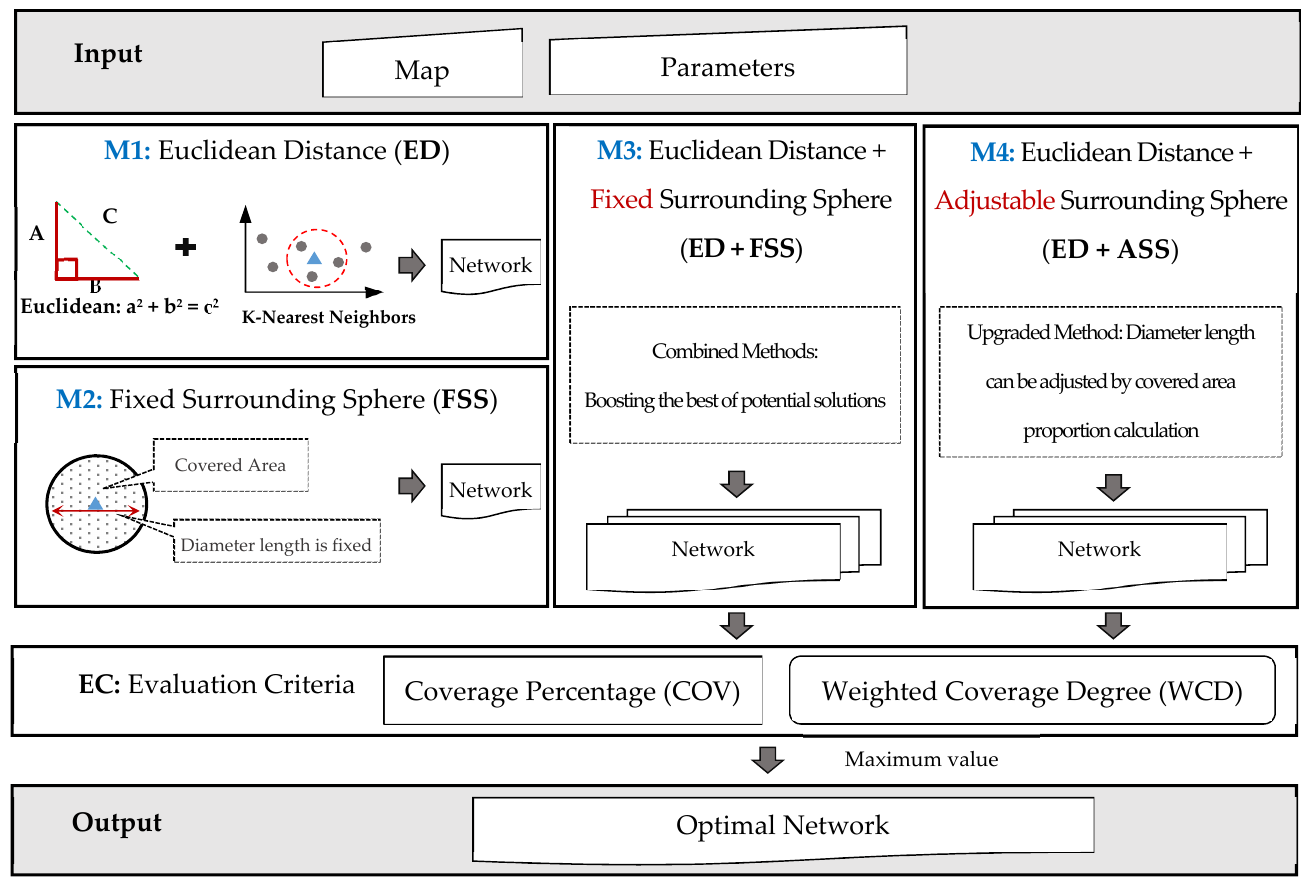
Figure 2. The framework of proposed methods.